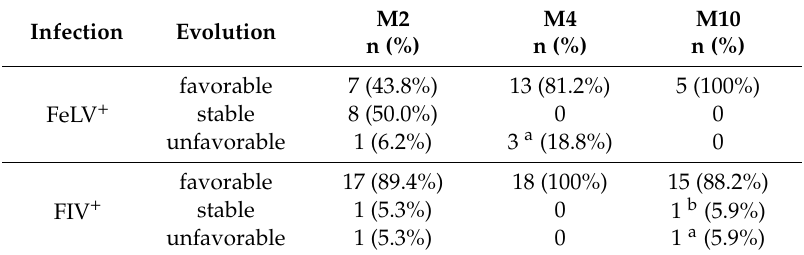
Table 2. Evolution at each visit of the clinical score (CS) of infected sick cats (CG2 and CG3) treated with rHuIFN- α compared to the beginning of treatment